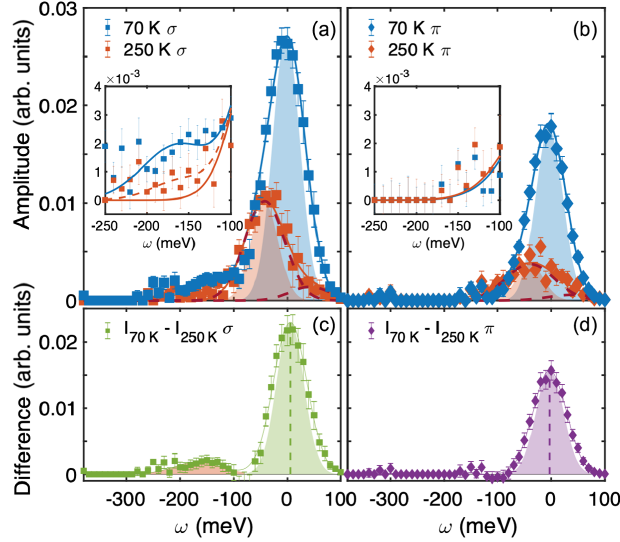
FIG. 3. Energy dependence for (a) σ and (b) π polarization of fitted Gaussian amplitude from energy-integrated data such as those shown in Figs. 2(a) – 2(d). The error bars indicate fit errors. Insets: Enlargement of the range ð − 250 ; − 100 Þ meV; the dashed red line in the inset of (a) indicates the possibility of nonzero charge scattering in this energy range at 250 K. Blue and red shaded areas indicate the instrument resolution of 60 meV (FWHM). Gaussian fits to Stokes and anti-Stokes scattering at FIG. 2. (a) – (d) σ -polarized RIXS intensity spectra at 70 and 250 K (dashed red lines; sum, solid red lines) yield 41(4) and 250 K, integrated over the 60 meV FWHM instrument resolution, 64(12) meV for the peak position and intrinsic (deconvoluted) centered at 0, 60, 120, and 180 meV energy loss. (e) σ - and FWHM peak width. Gaussian fits to three peaks at 70 K (blue (f) π -polarized RIXS spectra at 70 and 250 K, integrated over lines) capture (1) quasistatic, (2) low-energy ( ∼ 40 meV), and larger energy windows, as indicated. In all cases, the 70 K curves (3) high-energy [peak at 163(12) meV, intrinsic width of are vertically shifted for clarity. The black lines in (a) – (e) are 77(16) meV (FWHM)] contributions to the CDW response; polynomial momentum dependences, and the same in each case the latter is not discerned in π polarization, for which the charge at low and high temperature. Blue and red lines in (a) – (e) are fits response is expected and seen to be weaker [68]. (c),(d) Differ- to Gaussian profiles plus a smoothly varying contribution at 70 ence in amplitude between 70 and 250 K from (a) and (b), and 250 K, respectively. Blue and red lines in (f) are guides to the respectively, after correcting the 250 K data for the Bose factor. eye. Vertical dashed gray lines indicate q . The errors are one Green and purple shaded areas indicate the instrument resolution; CDW standard deviation (square root of total photon count). vertical dashed lines indicate peak centers obtained from fits to Gaussian profiles, which are consistent within error with zero energy transfer. The orange shaded area in (c) indicates the net response centered at 160(6)